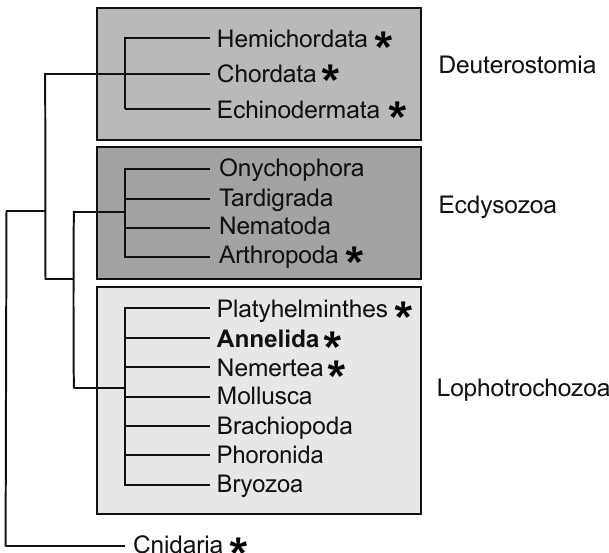
Figure 1. Simplified schematic of bilaterian phylogenetic tree. The three major clades that comprise the Bilateria are depicted by shaded boxes. Capitella teleta is a member of the Annelida within the Lophotrochozoa. Taxa with representatives that exhibit whole body or structural regeneration are indicated with an